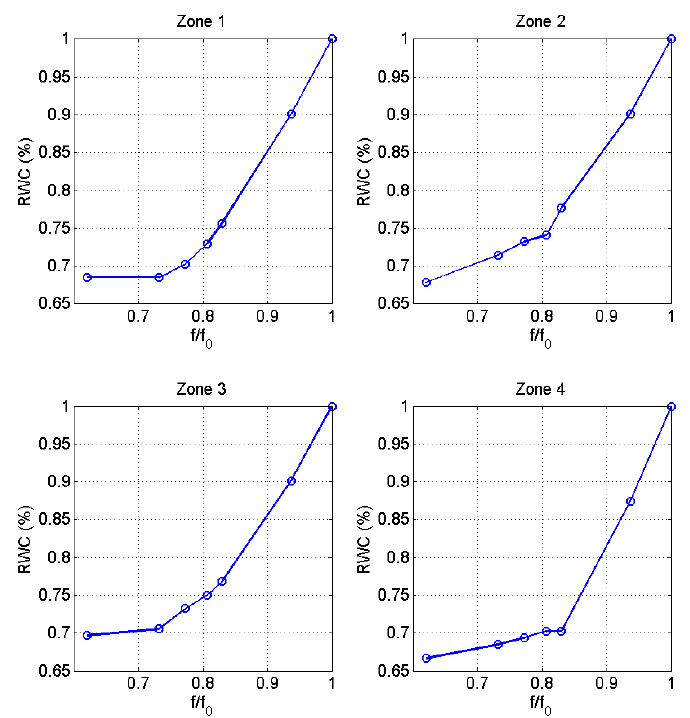
Figure 15. Variation in RWC as a function of the normalized resonance frequency in four different zones (R1, R2, R3 and R4, respectively) of the leaf.